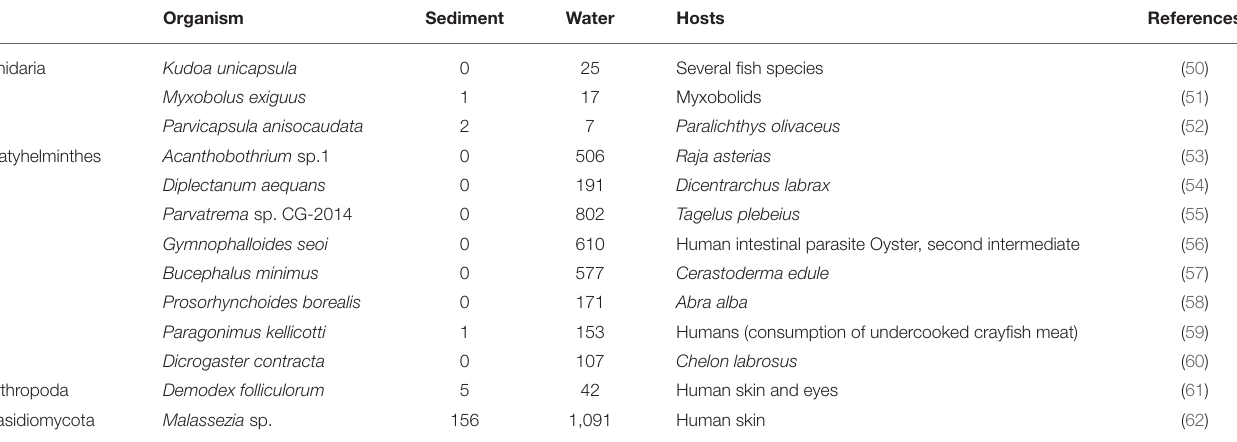
TABLE 4 | Diversity of potential pathogens included in the metazoan and fungi taxonomic groups detected in the